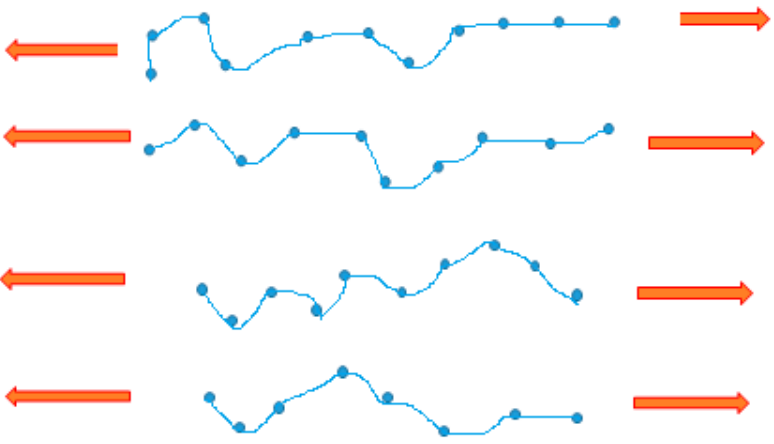
Figure 6. Rotation of the Kuhn segments resulting in alteration of polymer shape as a result of thermal vibration of atoms.